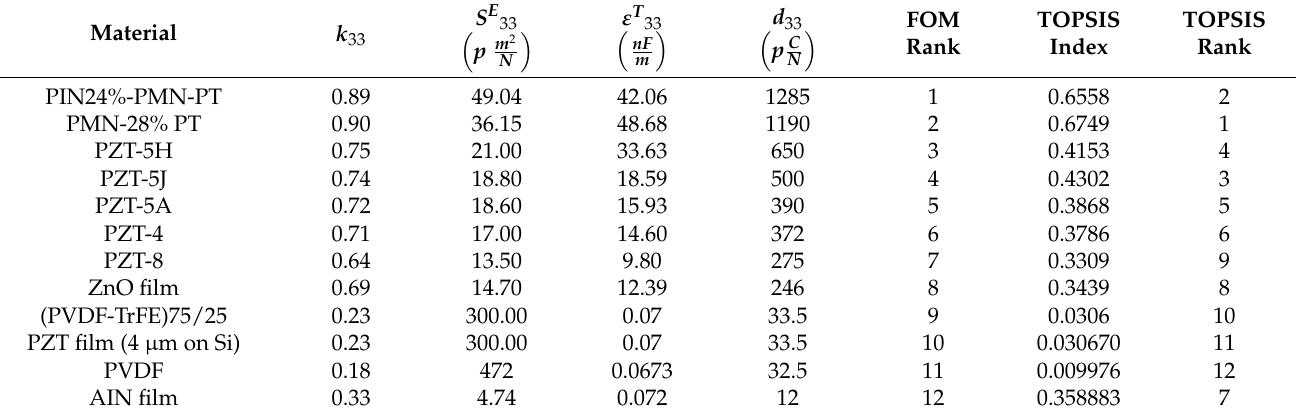
Table 3. Ranking of the piezoelectric materials for actuators according to FOM and TOPSIS